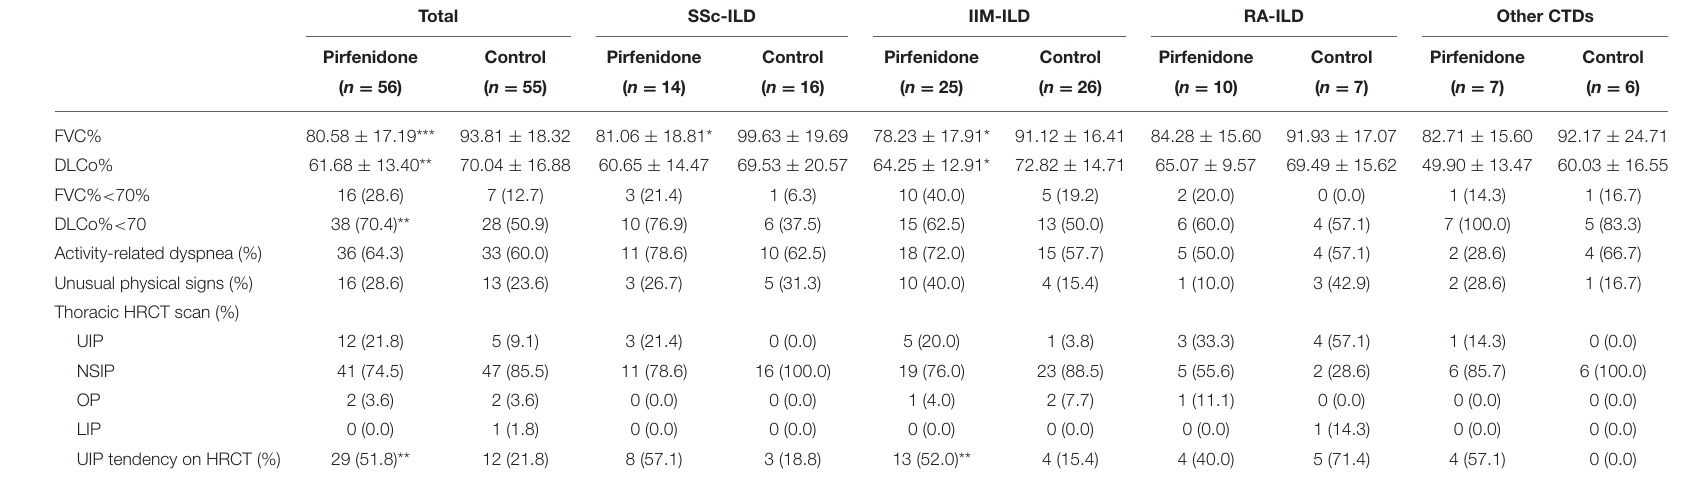
TABLE 2A | The baseline PF and HRCT imaging in PFD-treated and control groups of patients with CTD-ILD.